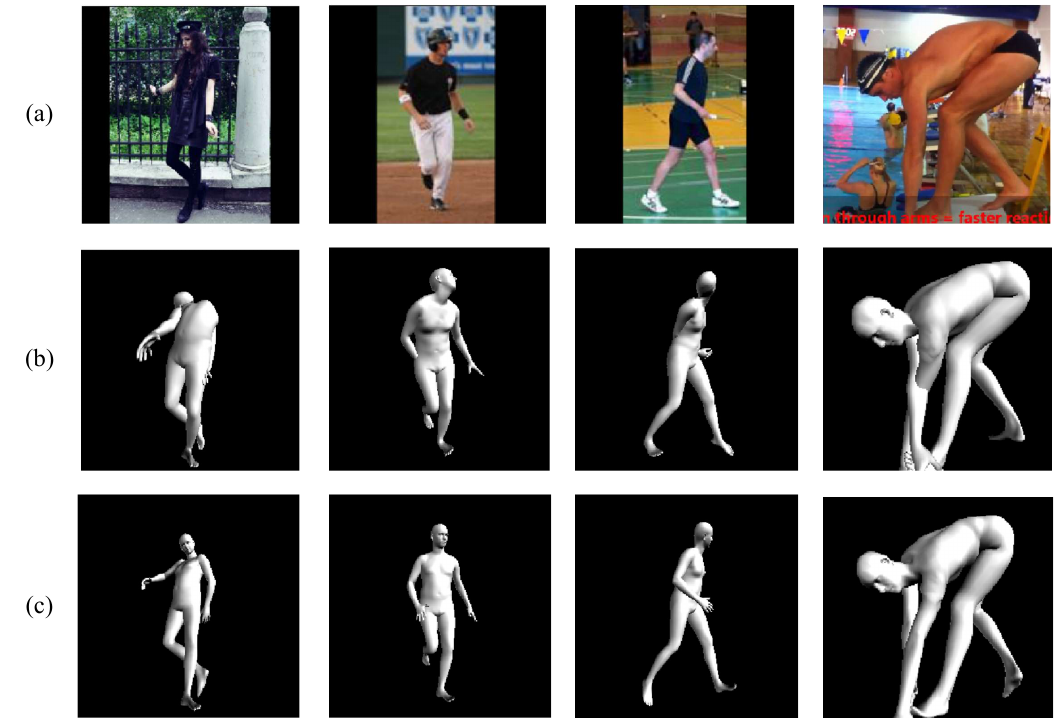
Figure 9. Visualized results of 3D pose estimation. Images in row ( a ) are the input images, images in row ( b ) are fitting results without SPT, images in row ( c ) are fitting results with